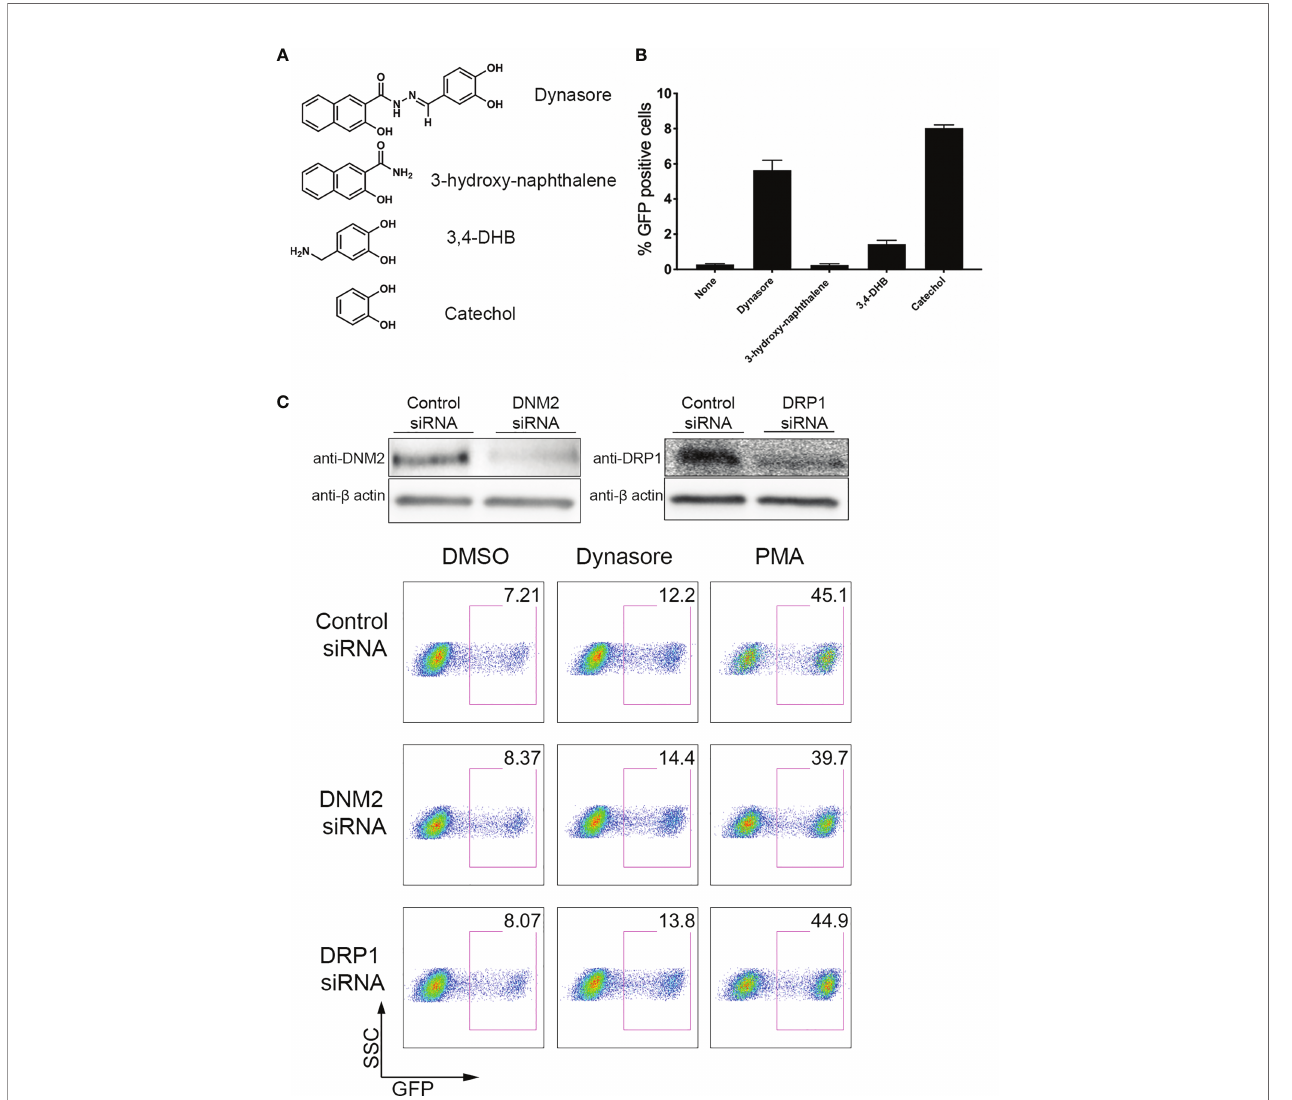
FIGURE 2 | Dynasore Structure Activity Relationship and dynamin-independent reactivation of latent HIV-1. (A) Chemical structures of components of Dynasore. (B) J-Lat 10.6 cells treated with 10µM Dynasore, Hydroxynaphthamide, 3,4-dihydroxybenzylamide (3,4-DHB) or Catechol for 24 hours. % GFP positive cells were measured by fl ow cytometry. Experiments were performed in triplicate. Data are represented as mean ± SD. (C) Immunoblot analysis of dynamin-2 (DNM2) and drp1 knockdowns in J-LAT 10.6 cell line. Control scramble siRNA and siRNA against dynamin-2 and drp-1 were introduced into J-LAT cell by Amaxa Nucleofection twice. After 24h, cells were either lysed for western blot analysis or incubated with/out solvent DMSO, 25 m M Dynasore or 5 ng/ml PMA for 24h and assessed for viral reactivation by fl ow cytometry. Data are representative of two independent